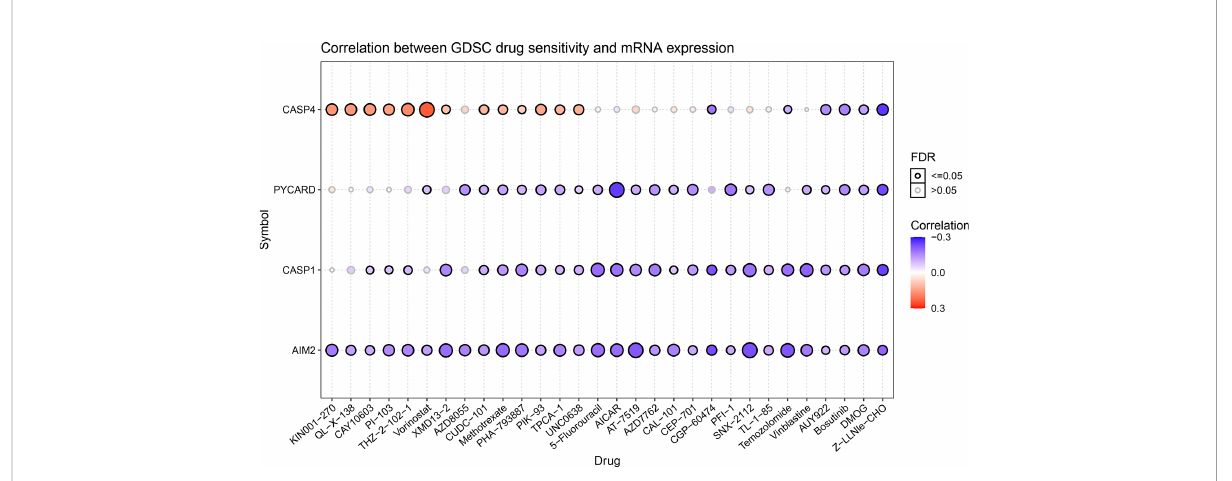
FIGURE 4 Drug sensitivity analysis of AIM2 in fl ammasome-related genes. Correlation of Genomics of Drug Sensitivity in Cancer(GDSC) drug sensitivity with mRNA expression. The shades of the color indicate the size of the correlation, red dots represent positive correlation and blue dots represent negative correlation. The size of the dots represents the statistical signi fi cance, the larger the dot, the higher the statistical signi fi cance (Spearman ’ s correlation test).